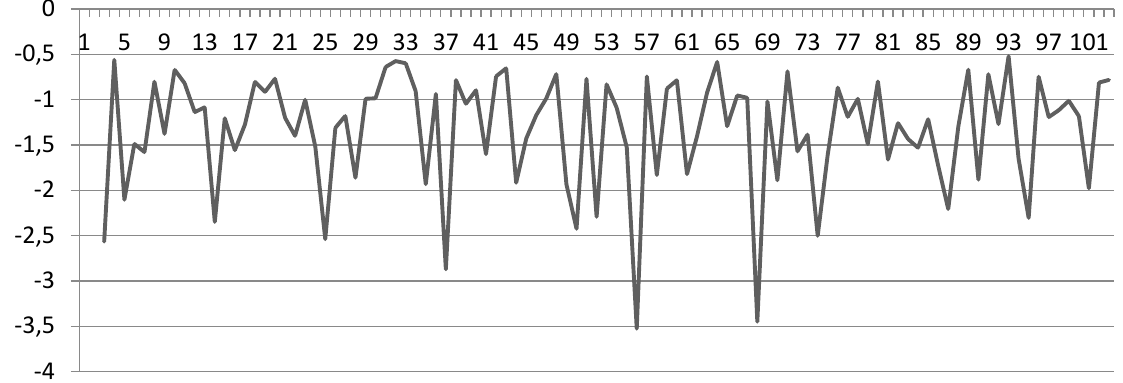
Figure 5. Majan College current ratio – Monte Carlo simulation results